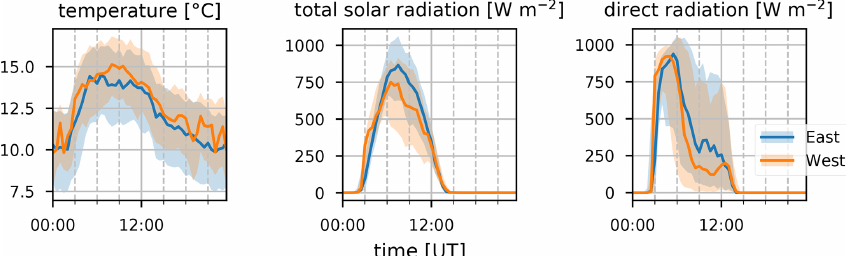
Figure 7. Median diel profiles (lines) and the interquartile distance (shaded area) for temperature, total solar radiation, and direct radiation (left to right) separated between easterly (blue) and westerly (orange) transport recorded at the